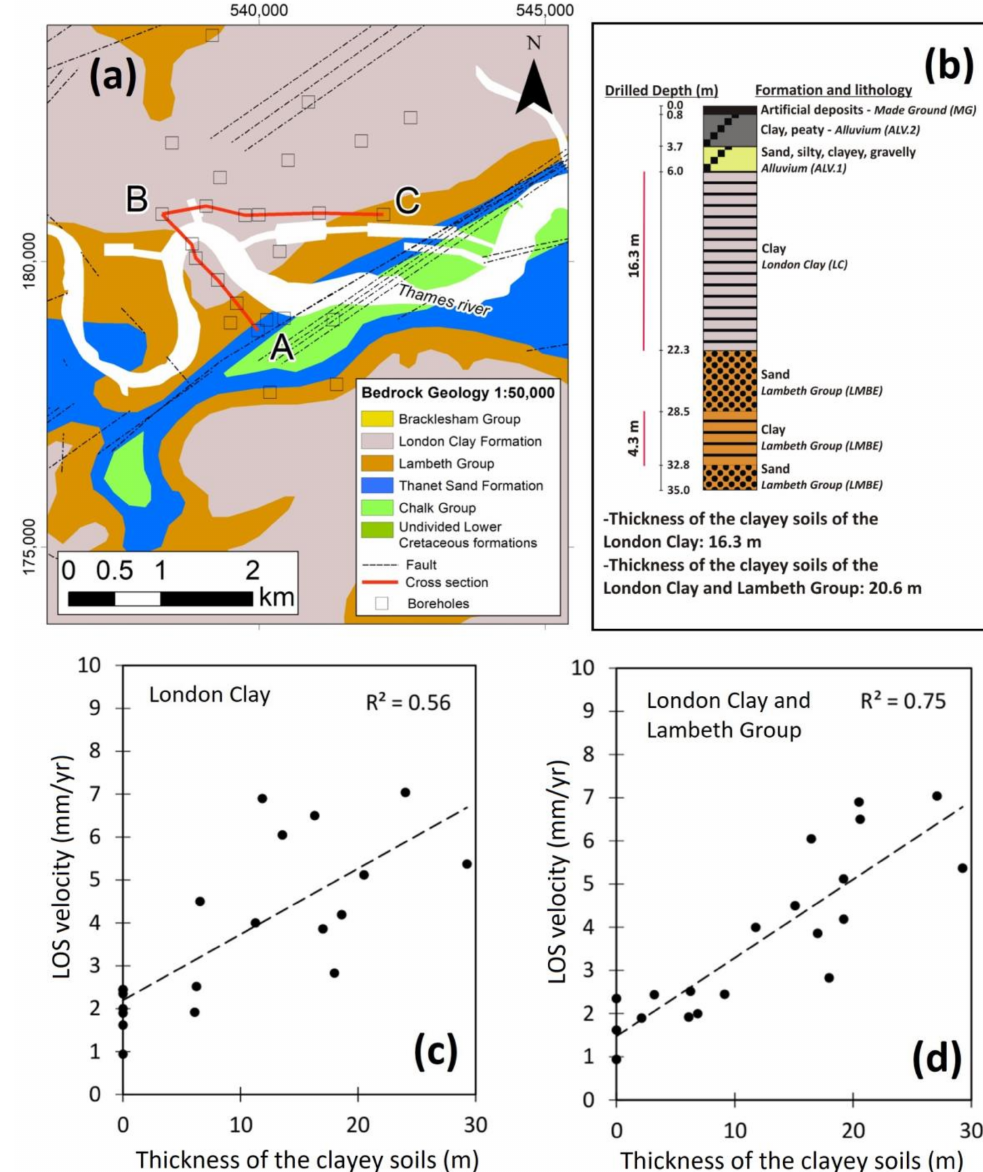
Figure 8. ( a ) Location of the boreholes used to estimate the thickness of the clayey soils. The cross sections (red line) are also reported; ( b ) Example of the procedure applied to estimate the thickness of the clayey soils of the London Clay and by computing the sum of the thickness of the clayey soils of the London Clay and Lambeth Group; ( c ) Comparison of the LOS velocity estimates in the period 2015–2017 with the thickness of clayey soils of the London clay using the boreholes information; ( d ) Comparison of the LOS velocity estimates in the period 2015–2017 with total thickness of clayey lithologies of the boreholes considering the London Clay and the Lambeth Group. Based upon the 1:50,000 bedrock geology, with the permission of the British Geological Survey. All rights